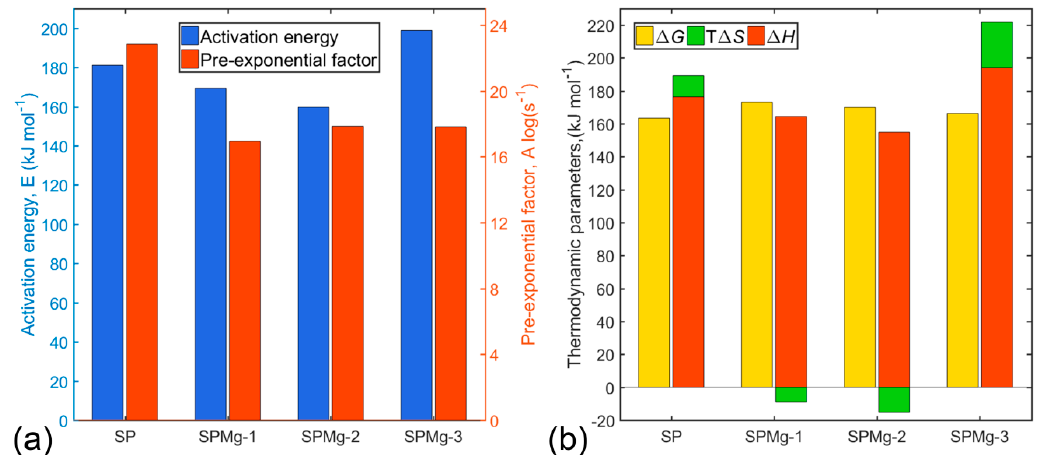
(cid:44) (cid:44) (cid:44) , T p ∆ S and ∆ H from polymer